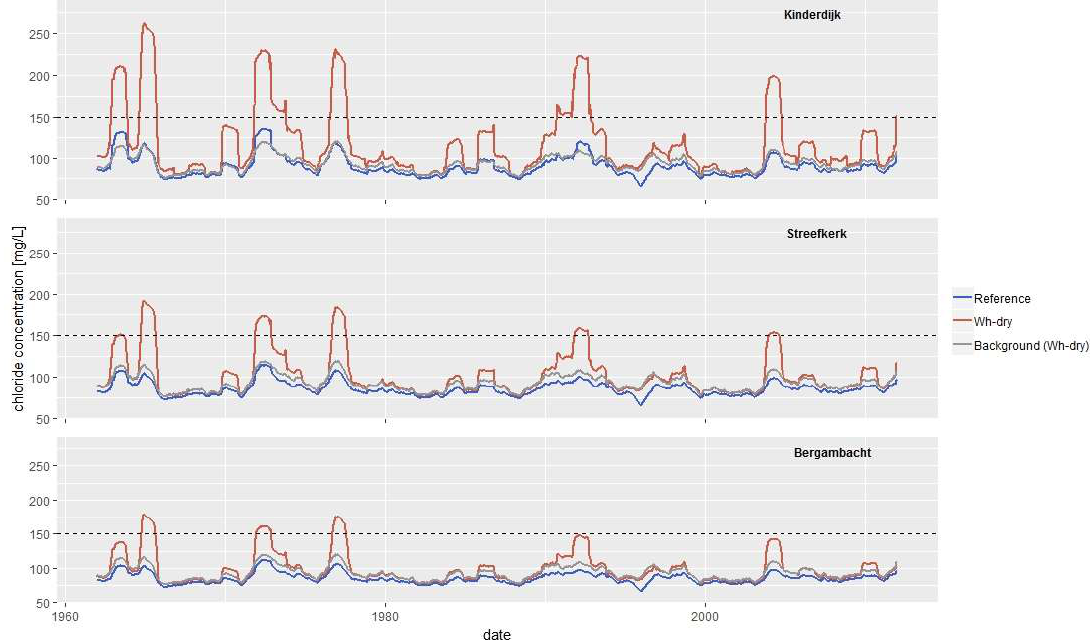
Figure 8. The 365-day moving average chloride concentration at the three drinking water inlet locations (based on calculations 1961–2011). The threshold level is 150 mg/L, averaged over the year, as a moving